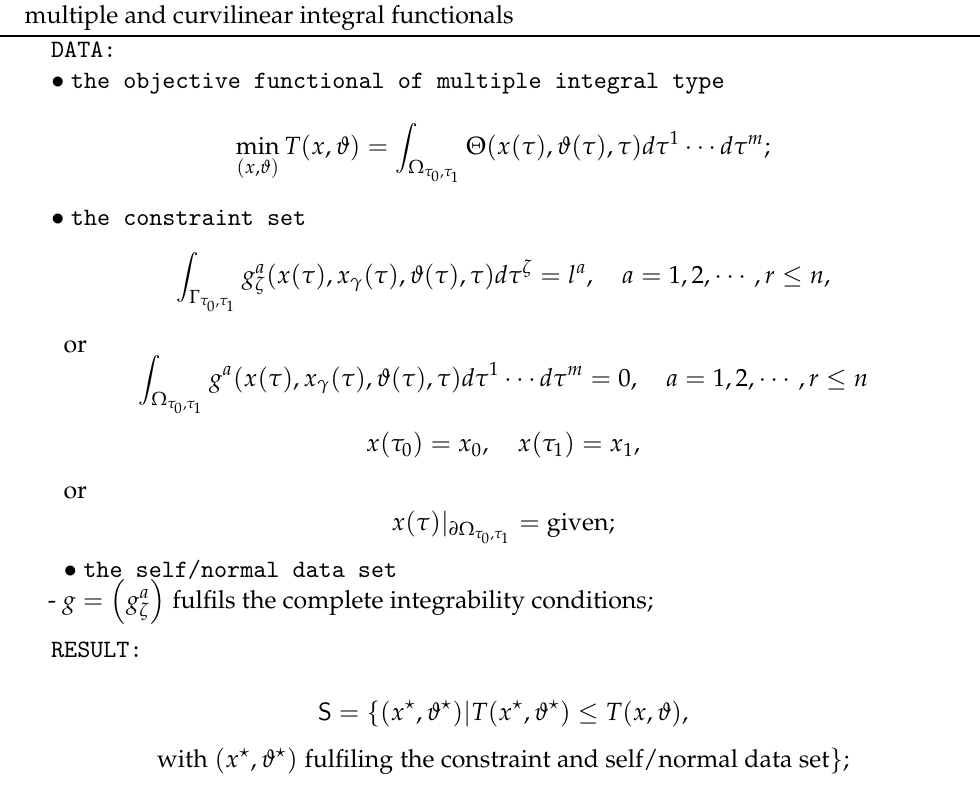
Algorithm 1: for new classes of constrained optimization problems involving multiple and curvilinear integral